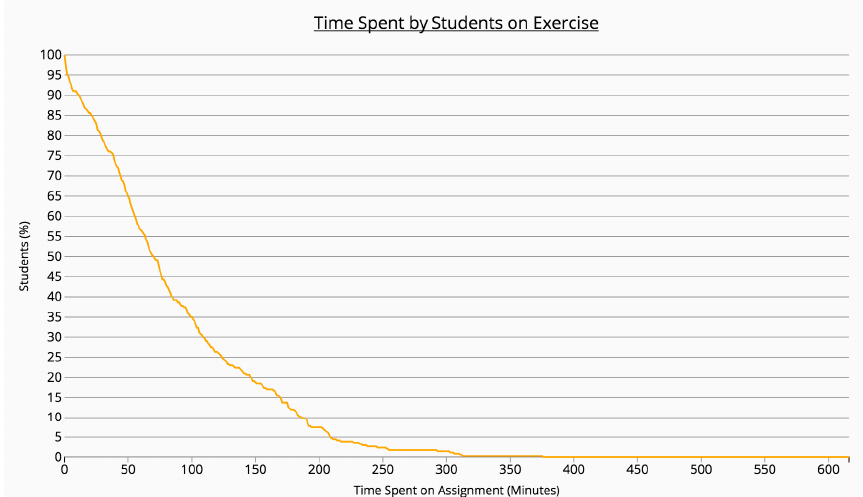
Fig. 3. The average time spent on the assignment by the participants was about one and a half hours. In comparison, we, the members of the teaching team spent a total of about 10 hours on the platform alone to create, maintain and troubleshoot the assignment. Addi- tionally, we spent at least as much time that has not been recorded on designing and implementing the